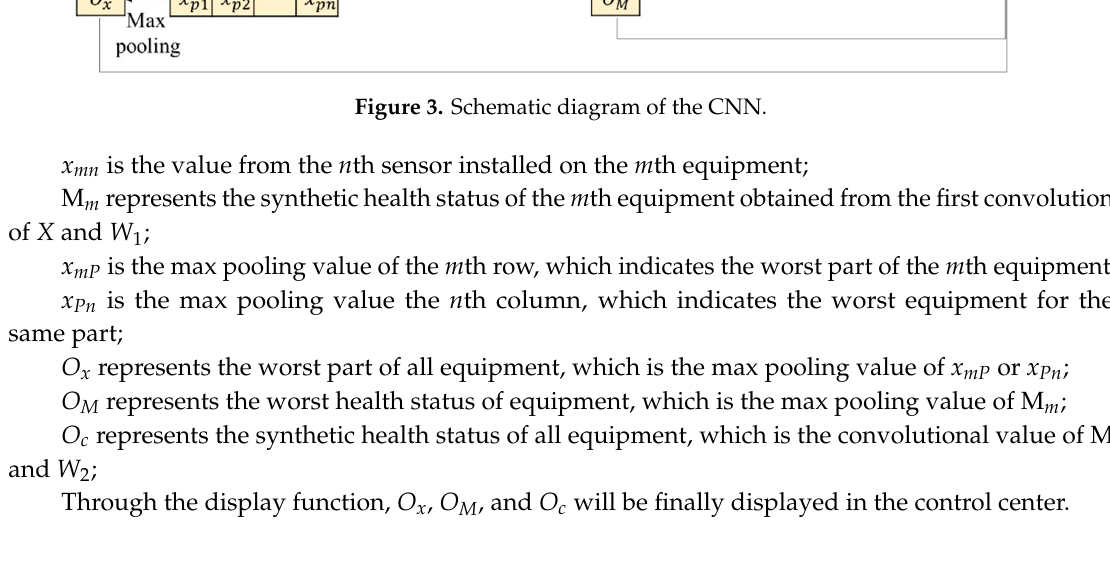
Figure 3. Schematic diagram of the CNN.